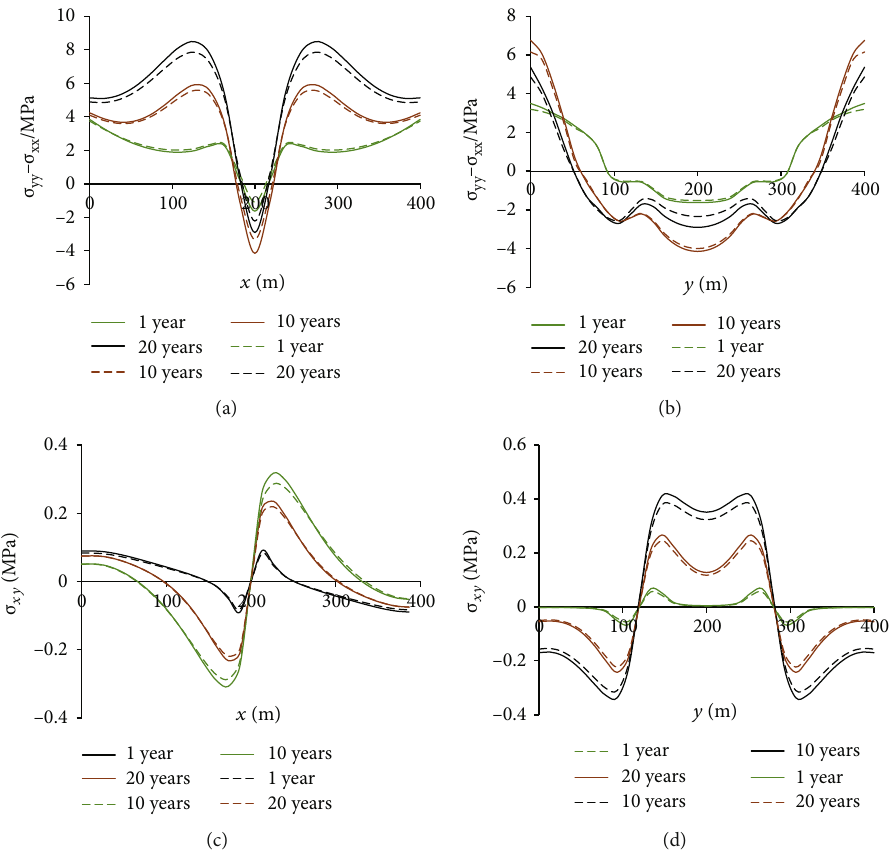
Figure 12: (a) and (b) are present the stress di ff erence pro fi les on Paths A and B of di ff erent production years, and (c) and (d) present the shear stress pro fi les on Paths A and B of di ff erent production years.